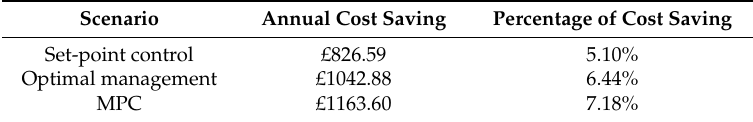
Table 5. The annual cost saving and percentage of cost savings to the annual electricity bill by using peak saving techniques for electrified RTG crane equipped with an energy storage system.